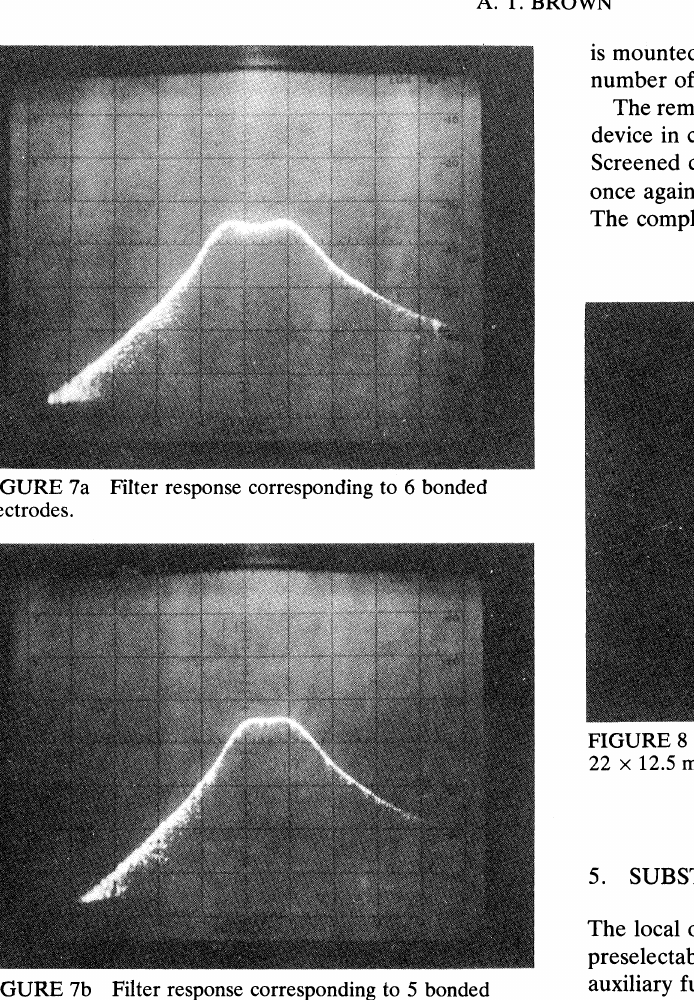
FIGURE 8 RF amplifier module. Package dimensions 22 12.5 mm.